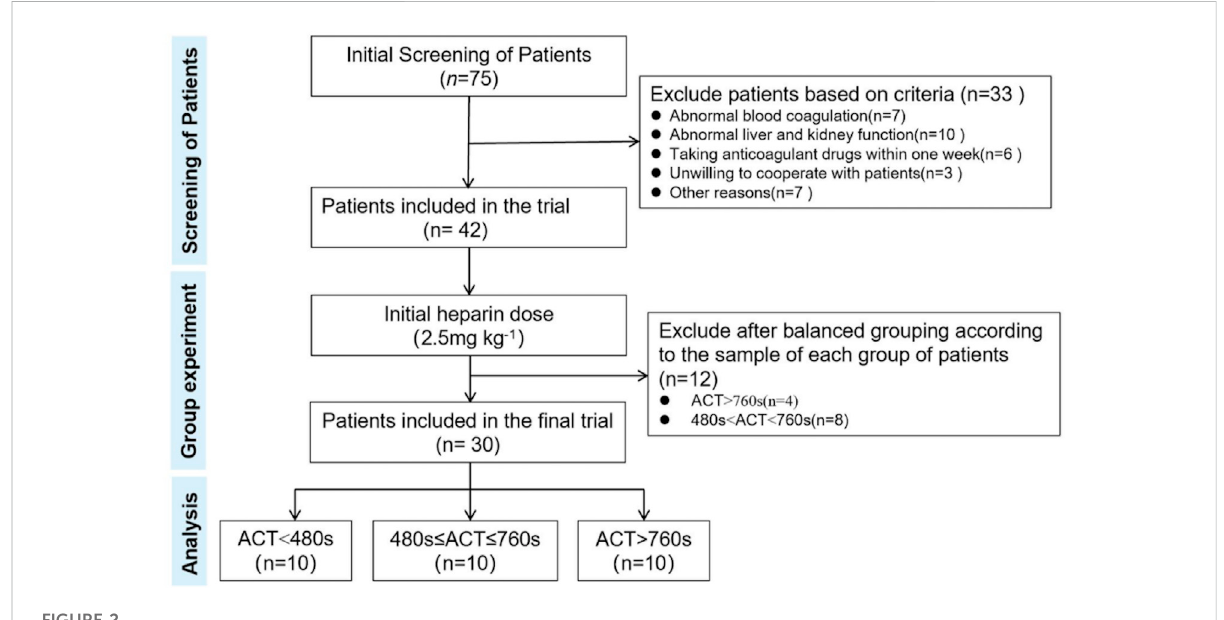
FIGURE 2 Flowchart for the inclusion of